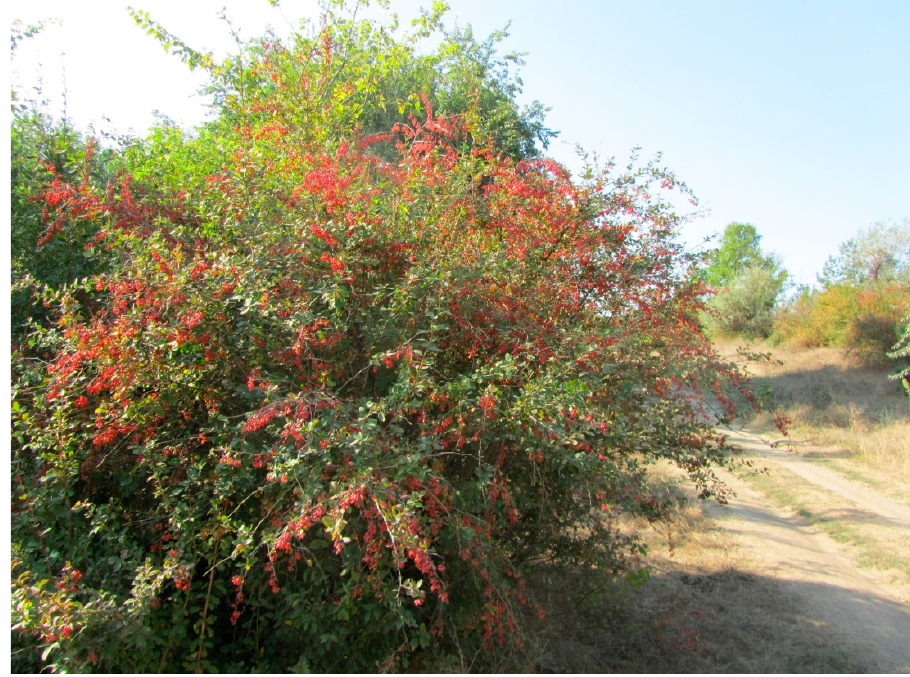
Figure 18. A fragment of the Berberis vulgaris-Cerasus mahaleb comm. on the artificial terrace (sur- roundings of Illinka village).